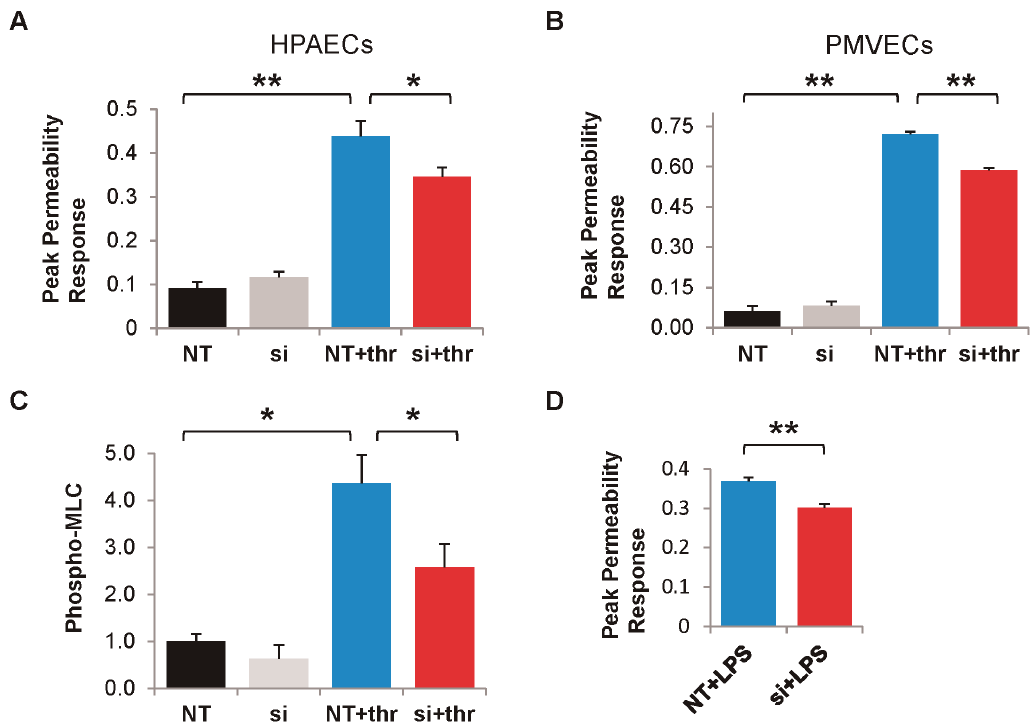
Figure 9. Cx43 knockdown attenuates permeability induced by thrombin or LPS. ( A. ) Graphs show the normalized permeability responses in HPAECs that were transfected with non-targeting (NT) or Cx43 (si) siRNAs for 48 hr and then left untreated or treated with 0.5 U/mL thrombin for 3 hr. (NT + thr and si + thr). Permeability response is given as (1– minimum normalized TER), where normalization is to TER at time point just prior to the first treatment. **, p , 0.001. *, p , 0.05. n=8 for NT or siRNA alone; n=11 for NT + thr group; n=13 for si + thr group. ( B. ) Graphs show the normalized permeability responses in Pulmonary Microvascular Endothelial Cells (PMVECs) that underwent identical siRNA transfection and thrombin treatment. **, p , 0.001. n=3 for NT + thr and si + thr groups; n=4 for NT group; n=3 for si groups. ( C. ) HPAECs were transfected with Cx43 or control siRNA for 48 hr, treated with thrombin (0.5 U/mL; 30 min) and collected for Western Blot. Phospho-MLC protein was normalized to b -actin relative to control. *, p , 0.05. n=6 for each condition. ( D. ) Graphs show the normalized permeability responses in siRNA-transfected HPAECs that had been treated with 200 ng/mL lipopolysaccharide (LPS) for 24 hr. **, p , 0.001. n=7 for each group. NT=non-targeting siRNA, si=siRNA-Cx43. Thr=thrombin.